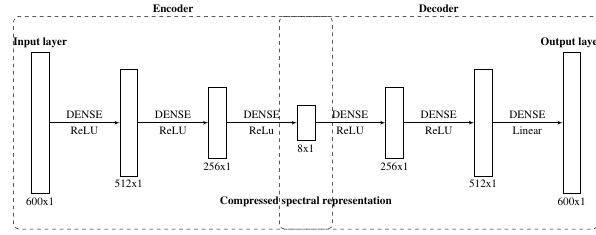
Figure 4. The structure of the DAE for the spectral range